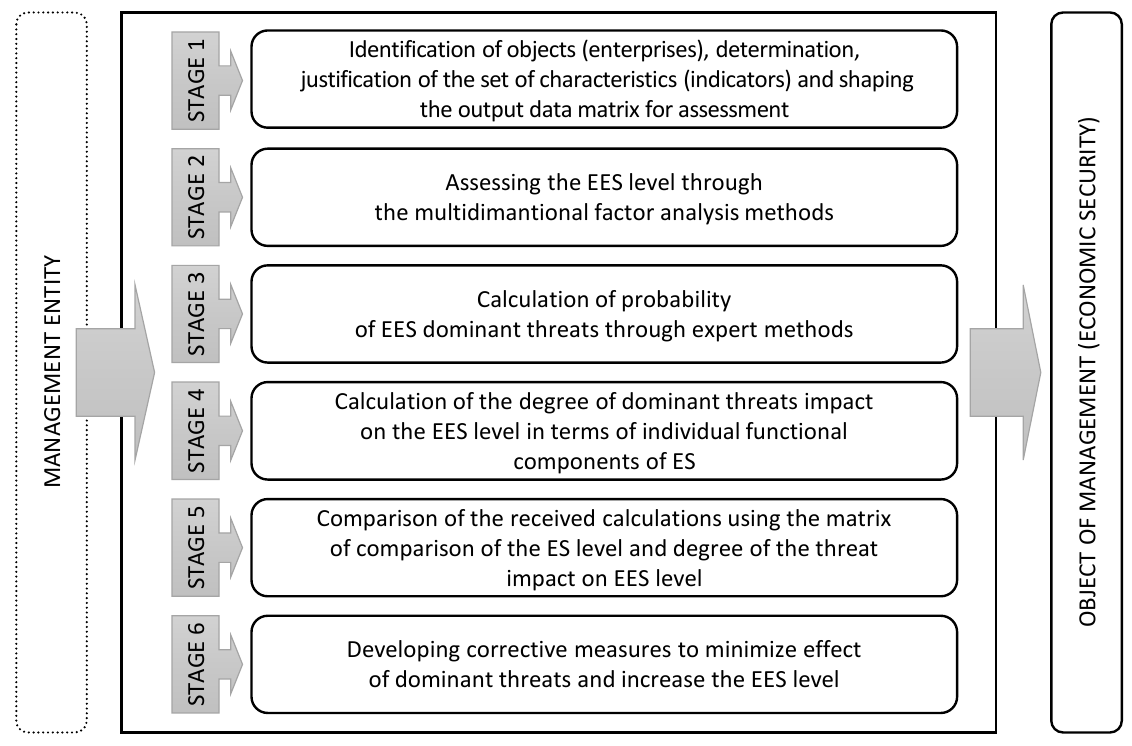
Table 3. Matrix for comparing the indicator value of the EESM efficiency and the total degree of threats impact on the economic security